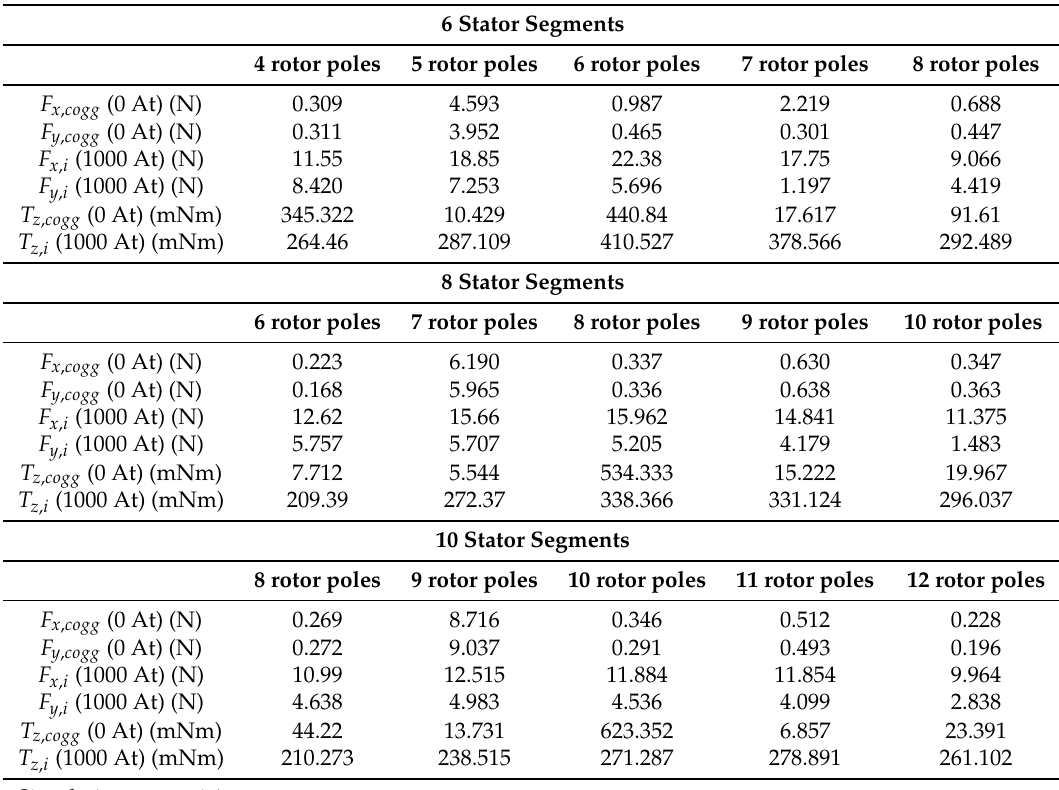
Table 3. Simulation results for different Q S / Q R topologies.